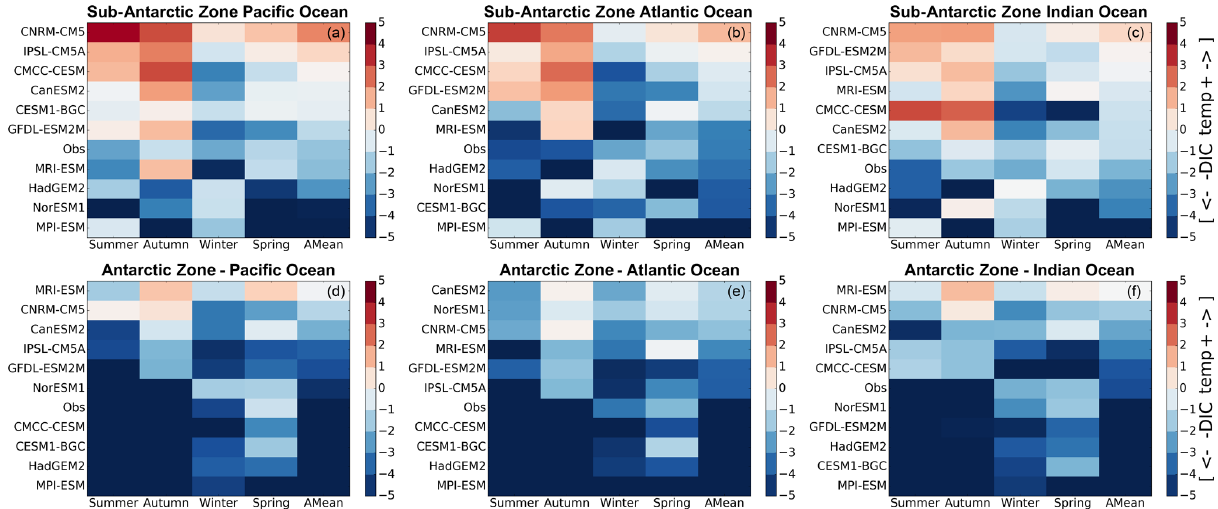
Figure 6. Mean seasonal and annual values of the DIC–temperature control index ( M T -DIC ) . The increase in the red color intensity indicates increase in the strength of the temperature driver and the blue intensity shows the strength of the DIC driver. The models are sorted according to the annual mean value of the indicator presented in the last column